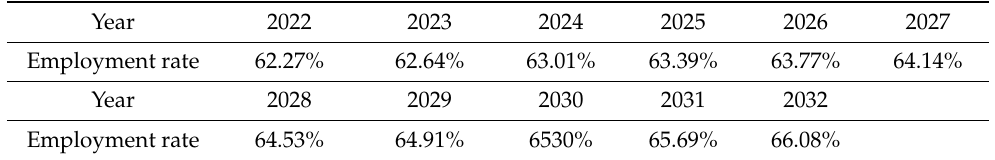
Table 4. Assumptions of the employment rate of the labor force in Anhui from 2022 to